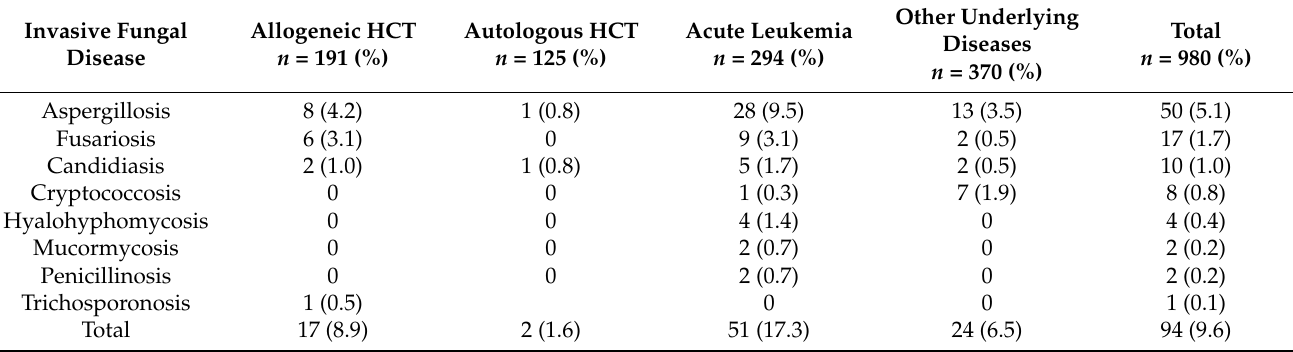
Table 2. Frequency and etiology of invasive fungal disease in 316 hematopoietic cell transplant recipients and in 664 patients with hematologic